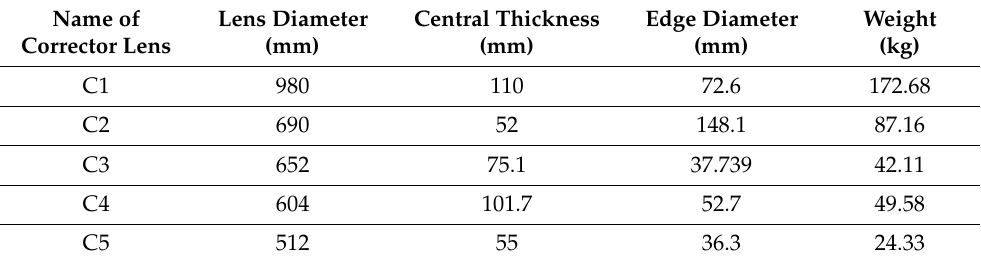
Figure 2. Schematic cross-section of DECam’s camera [15]. Table 2. The dimensions of DECam’s corrector